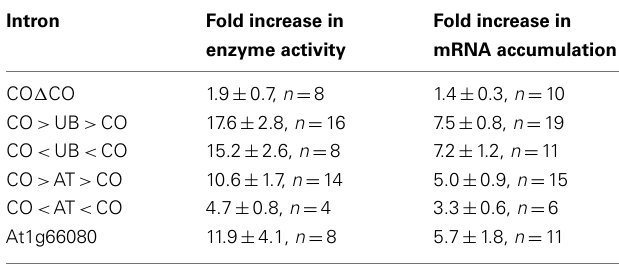
Table 1 |The effect of different introns on TRP1:GUS